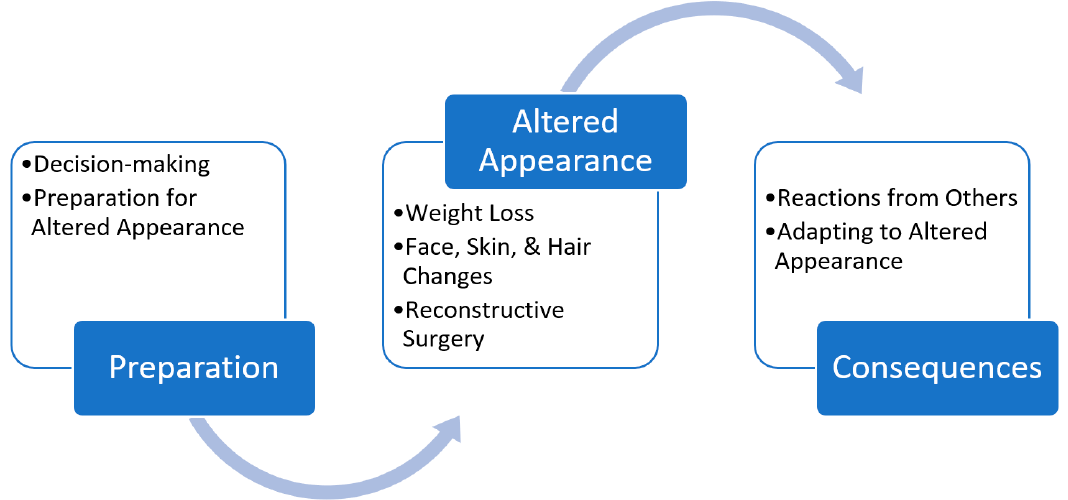
Figure 1. Themes and Sub-themes.